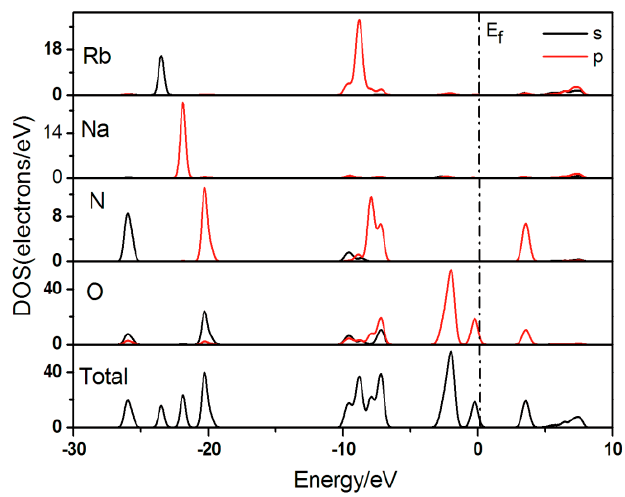
Figure 5. Total and partial densities of states (DOS/PDOS) for Rb 2 Na(NO 3 ) 3 .